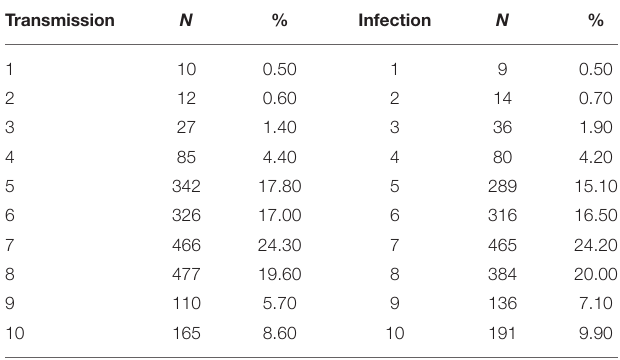
TABLE 4 | Descriptive results of the knowledge about COVID-19 ( N = 1,920). Transmission